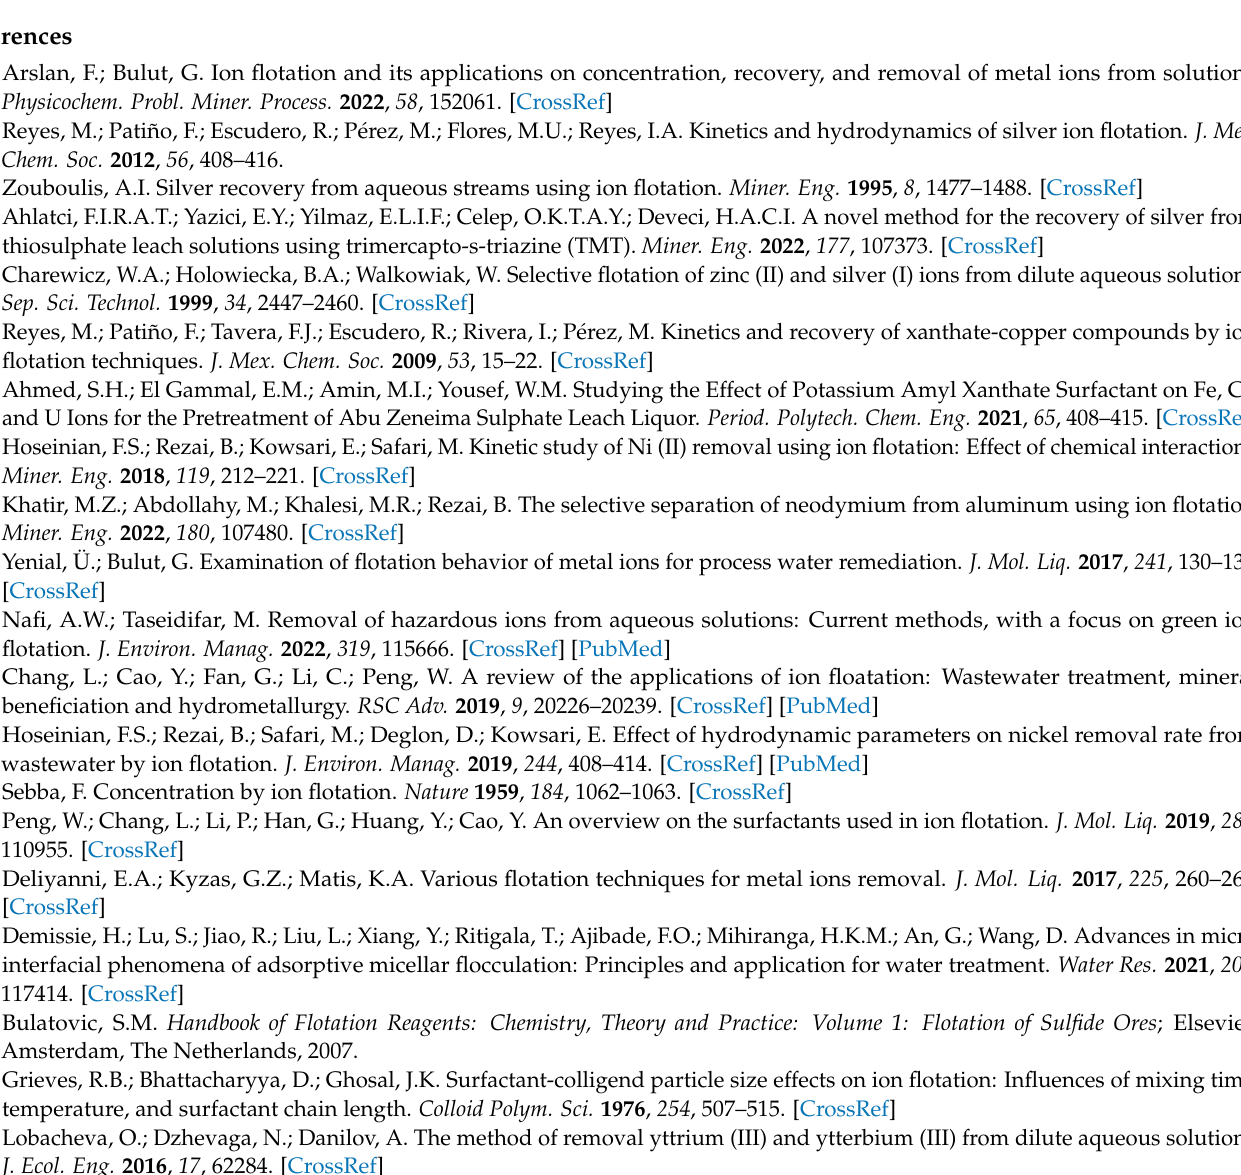
feed. Table S2: Calibration of the peristaltic discharge pump (tails). Table S3: Calculation of